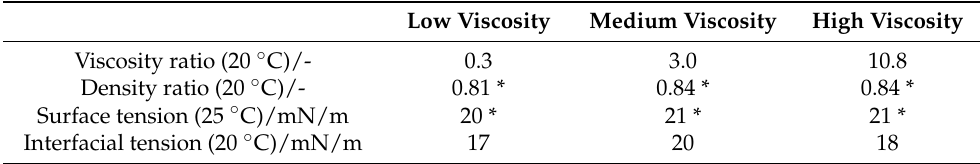
Table 3. Properties of the three different viscosity ratio systems.